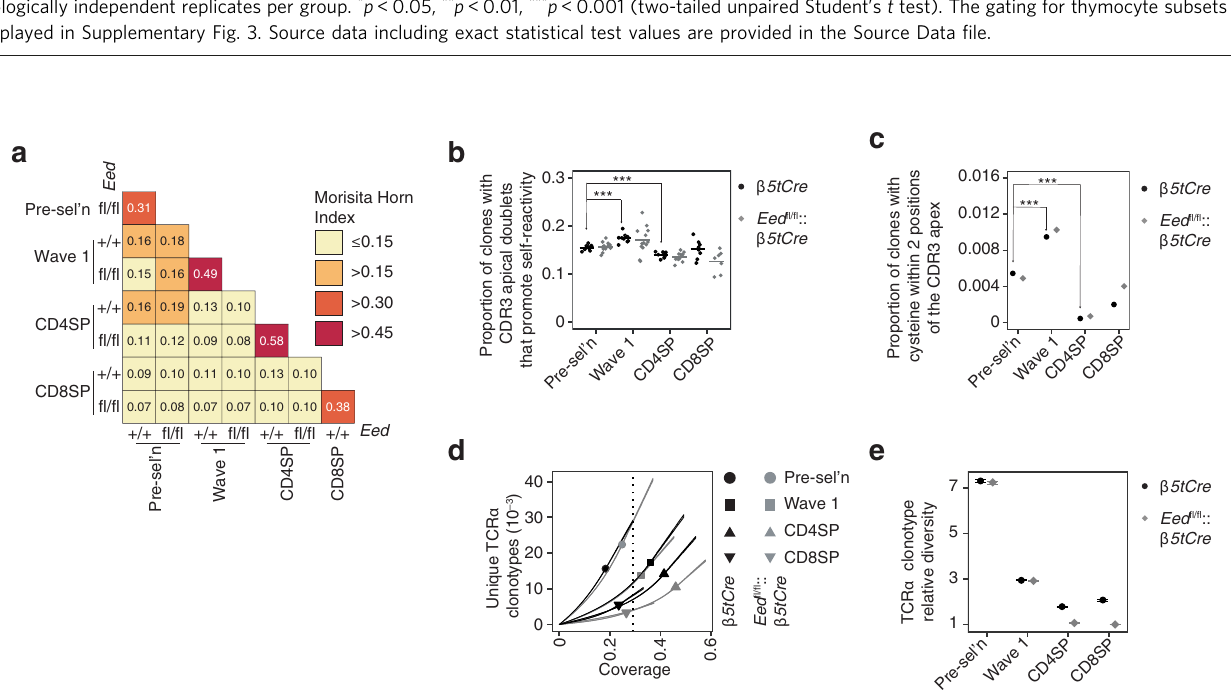
Fig. 5 TCR α repertoire analysis of YAe62 TCR β -transgenic thymocytes in β 5tCre or Eed fl / fl :: β 5tCre bone marrow chimeras. Unless stated otherwise, the analyses compared TCR catalogues, which were formed by aggregating samples of a given T cell subset/genotype combination. The β 5tCre and Eed fl / fl :: β 5tCre TCR catalogues contained the following numbers of samples: 9 and 14 mice, respectively (pre-selection, Wave 1 and CD8SP); 8 and 14 mice, respectively (CD4SP). a Heatmap shows the Morisita-Horn index for each pair of TCR catalogues. b, c Amino acid composition of the CDR3 apex. Considering the amino acid doublets at CDR3 positions 6 and 7, ( b ) shows the proportion of TCR α clones with doublets that promote self-reactivity 33 . Each symbol represents an individual sample. Samples with fewer than 100 clones were excluded, ( c ) depicts the proportion of TCR α clones with cysteine anywhere from CDR3 position − 2 to + 2 as determined by apex-out CDR3 alignment 35 . *** p = 4.3 × 10 − 5 (pre-selection vs. Wave 1) and p = 1.7 × 10 − 6 (pre-selection vs. CD4SP) using Student ’ s t test (unpaired, two-sided, Bonferroni-corrected) in ( b ) or p = 1.5 × 10 − 6 (pre-selection vs. Wave 1) and p = 2.8 × 10 − 15 using Fisher ’ s exact test (2 × 2 table, two-sided, Bonferroni-corrected) in ( c ). d , e TCR α clonotype diversities. d Cumulative number of unique TCR α clonotypes plotted as a function of “ coverage ” , de fi ned as the proportion of all clones (encountered and unencountered) in a given T cell subset that belong to clonotypes encountered in the catalogue. Symbols show the observed values and curves outline the 95% con fi dence intervals of the rarefaction and extrapolation curves determined using 10 bootstrap replications. e Relative diversity of TCR catalogues. Symbols indicate ratios of the numbers of unique TCR α clonotypes per TCR catalogue at the level of coverage indicated by the vertical dashed line in ( d ). Error bars in ( e ) show the 95% con fi dence intervals of the relative diversities of TCR catalogues based on 10 bootstrap replications. subtle reduction in the breadth of promiscuous gene expression in level in ZsGreen-positive and -negative mTEChi of experimental mTEChi pro fi cient or de fi cient in PRC2 activity within the same mice and their controls (Fig. 10a). By randomly sampling AIRE thymic environment. However, multivariate analysis showed that expressing single cells, we estimated for each of the different the presence of H3K27me3 marks near the TSS predicted whether mTEC populations the number of detectable genes encoding or not a gene was upregulated in EED-de fi cient mTECs relative to TRAs (Fig. 10b). The breadth of promiscuous TRA expression those that were EED-pro fi cient independently of whether or not was reduced in EED-de fi cient mTECs, affecting particularly that gene was regulated by AIRE (Supplementary Fig. 10b). This AIRE-controlled loci (AIRE-dependent: 0.86-fold, p < 0.0001; fi nding suggests that at least a portion of the mild de fi ciency in AIRE-enhanced: 0.96-fold, p < 0.0001; AIRE-independent TRA: promiscuous gene expression was more likely to be driven by 0.98-fold, p < 0.0001; all other genes: 0.99-fold, p < 0.0001). A thymic microenvironmental changes than a direct effect of EED- similar change in the pattern of TRA expression was observed in de fi ciency. Eed fl / fl :: β 5tCre mice did not develop auto-antibodies or ZsGreen-negative mTEC isolated from Eed fl / fl :: ZsGreen :: β 5tCre mice (AIRE-dependent: 0.84-fold, p < 0.0001; AIRE-enhanced: overt organ in fi ltration nor did they reveal signs of autoimmunity 0.94-fold, p < 0.0001; AIRE-independent TRA: 0.97-fold, p < after antibody-mediated T cell depletion and subsequent 0.0001; all other genes: 0.99-fold, p < 0.0001). Hence, there was a endogenous T cell reconstitution (Supplementary Fig. 11). NATURE COMMUNICATIONS| (2021) 12:3933